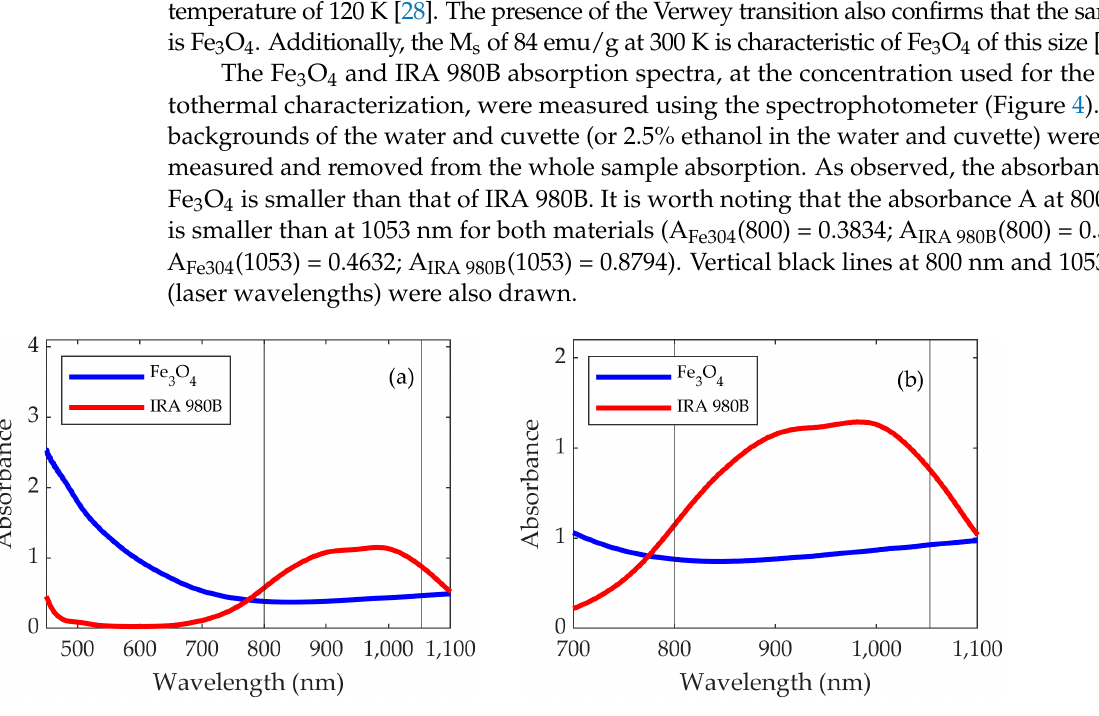
Figure 4. ( a ) Absorbance of the Fe 3 O 4 (blue) and IRA 980B (red). ( b ) Zoom on the near-infrared area, where the lasers operate. Vertical black lines correspond to the laser wavelengths at 800 nm and 1053 nm.